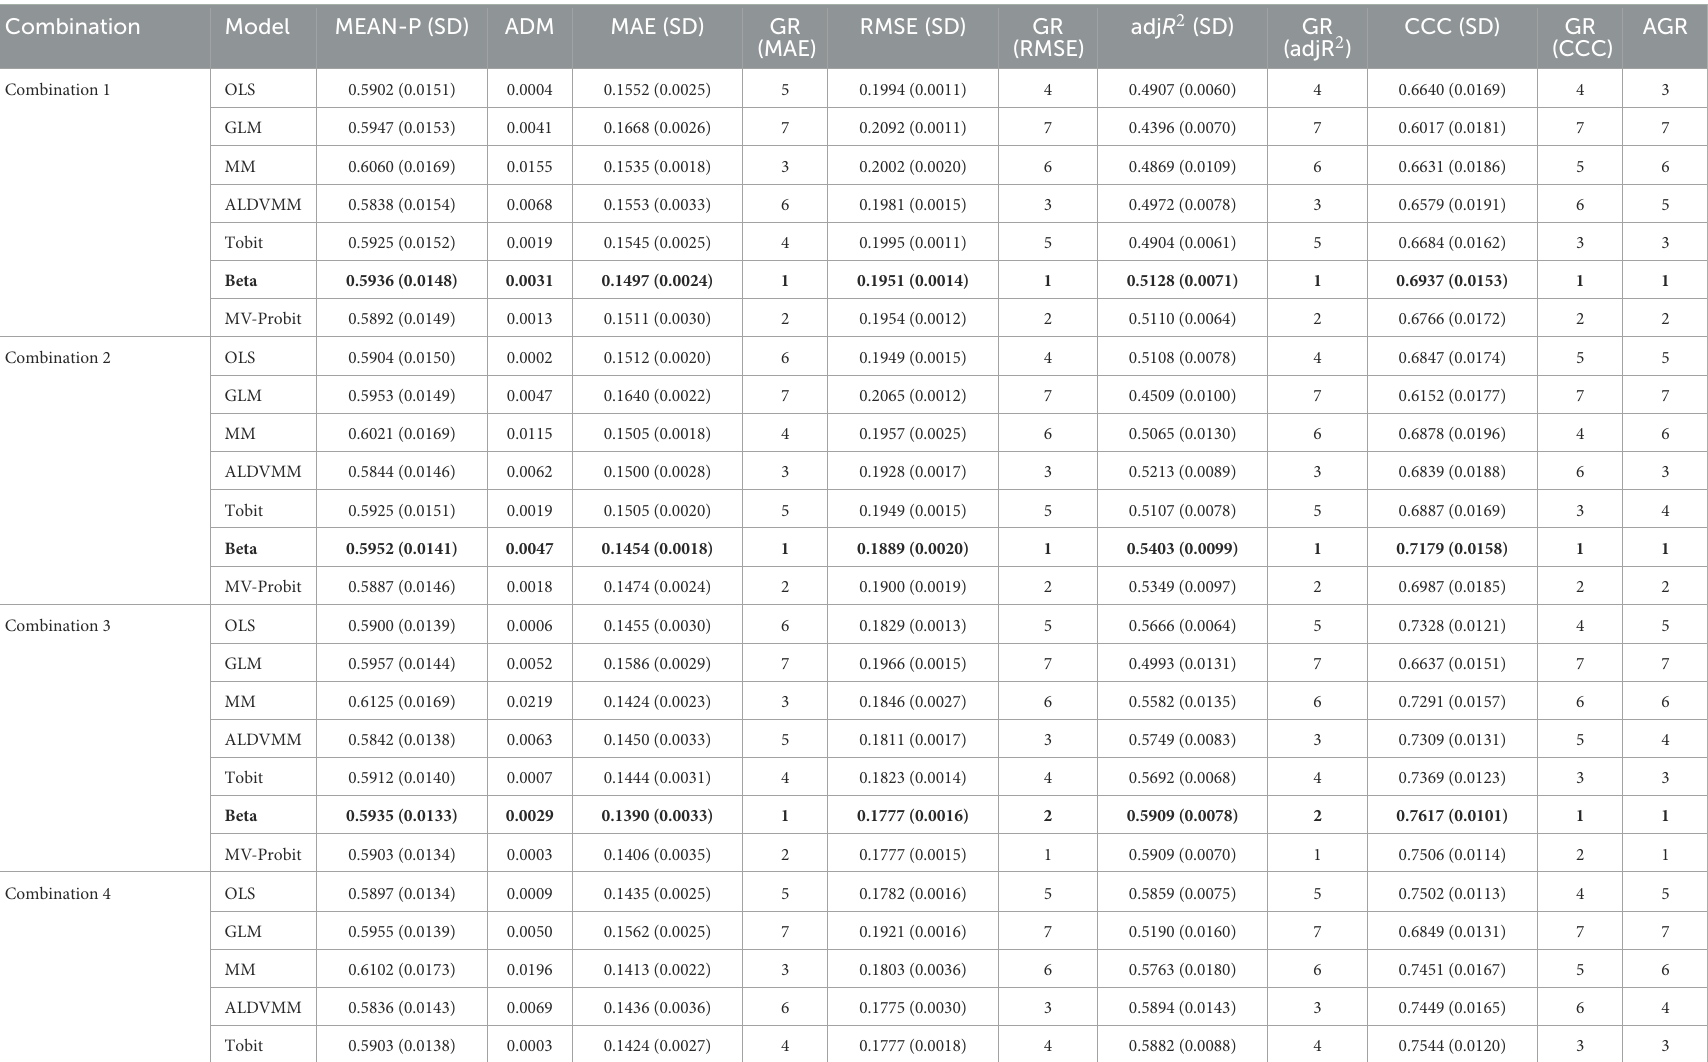
TABLE 3 The results of mapping algorithms